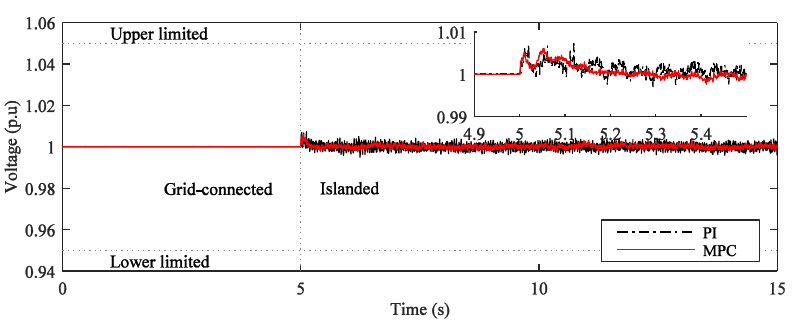
Figure 8. Frequency of microgrid system.